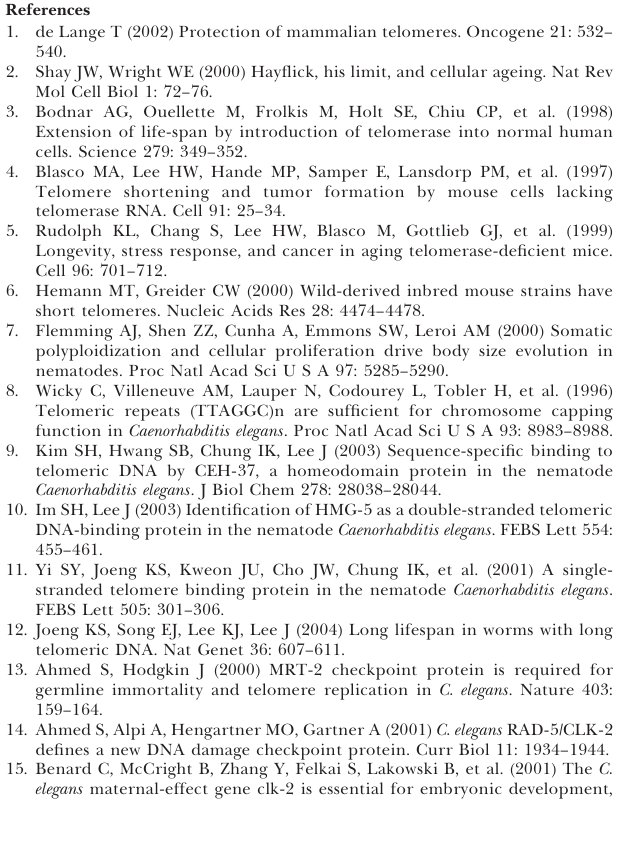
Figure S1. Organismal Life Span Is Independent of Telomere Length (A) Life span of control N2 worms (green), daf-2(e1370) mutants (blue), and daf-16(mu86) mutants (red). Life span was assessed as described [21].